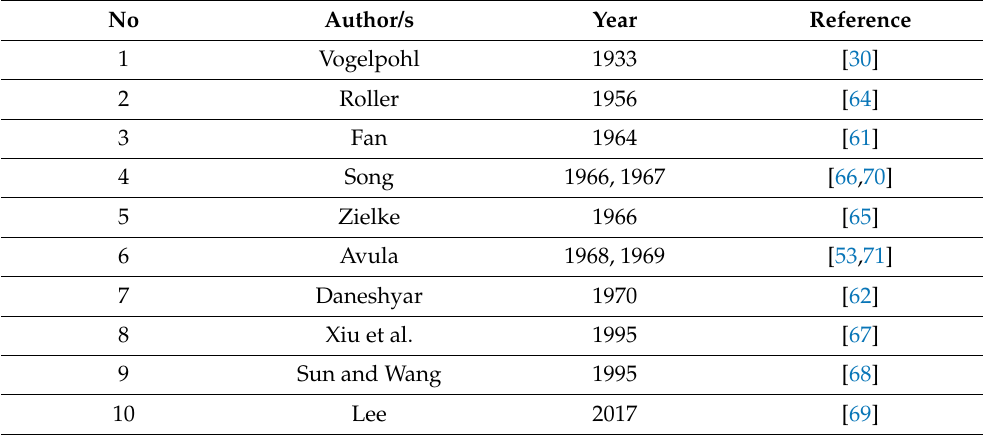
Table 1. A list of works in which a universal formula was